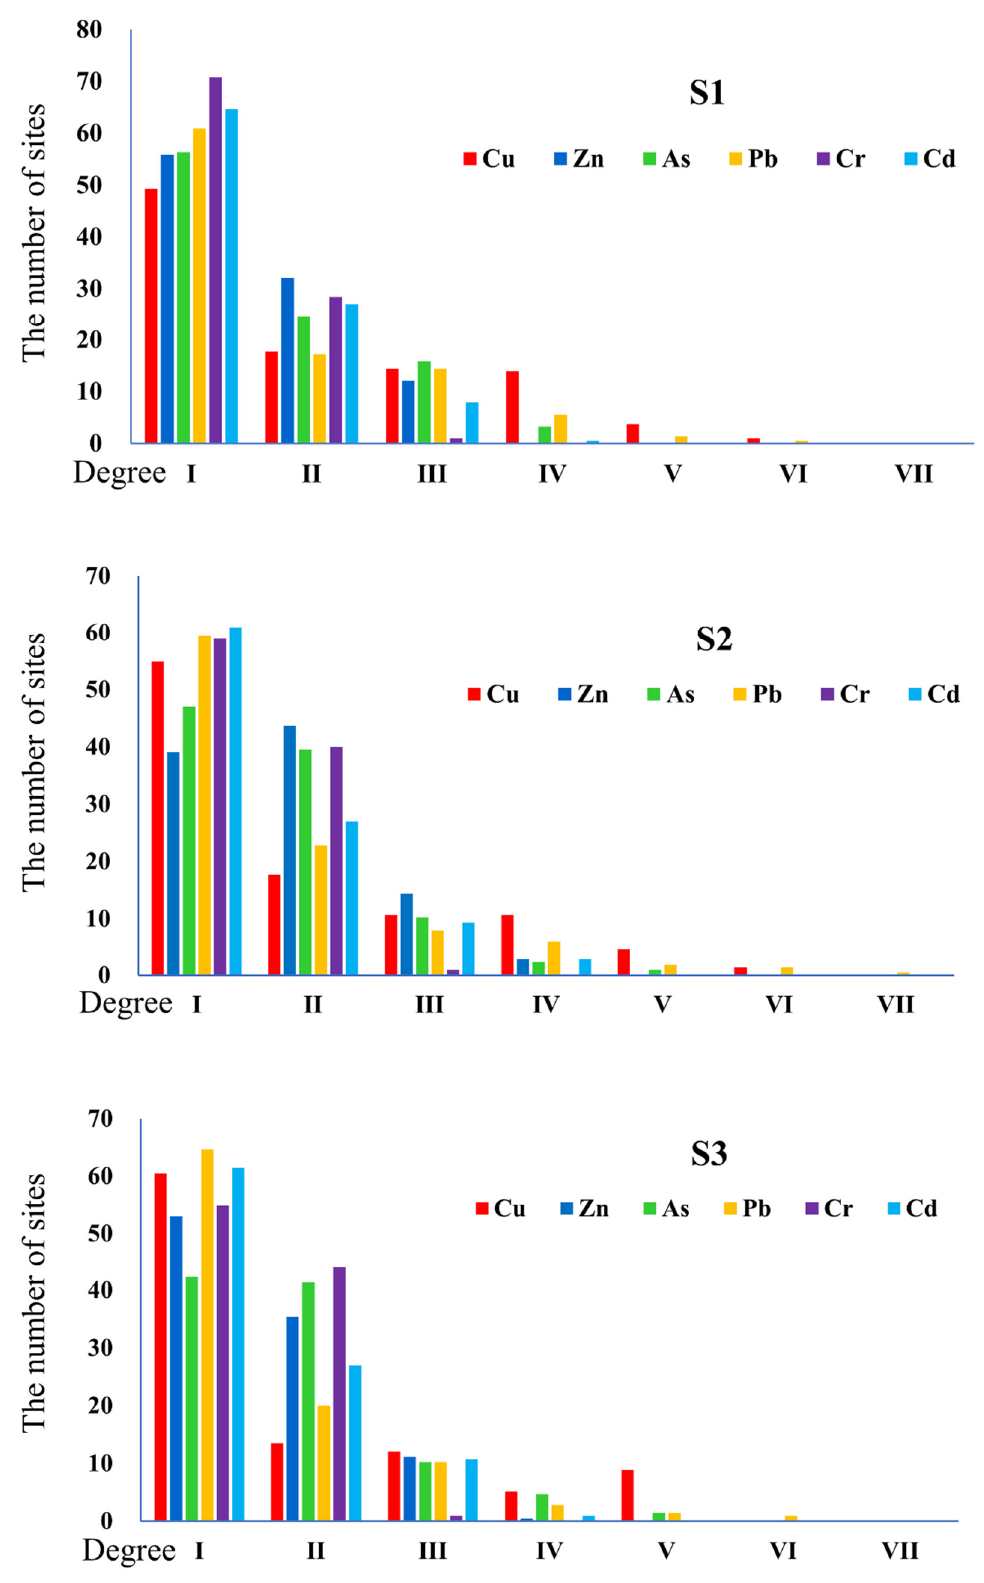
Figure 3. The results of pollution degree base on I geo. S1: 0–10 cm soil layer; S2: 10–30 cm soil layer; S3: 30–50 cm soil layer.